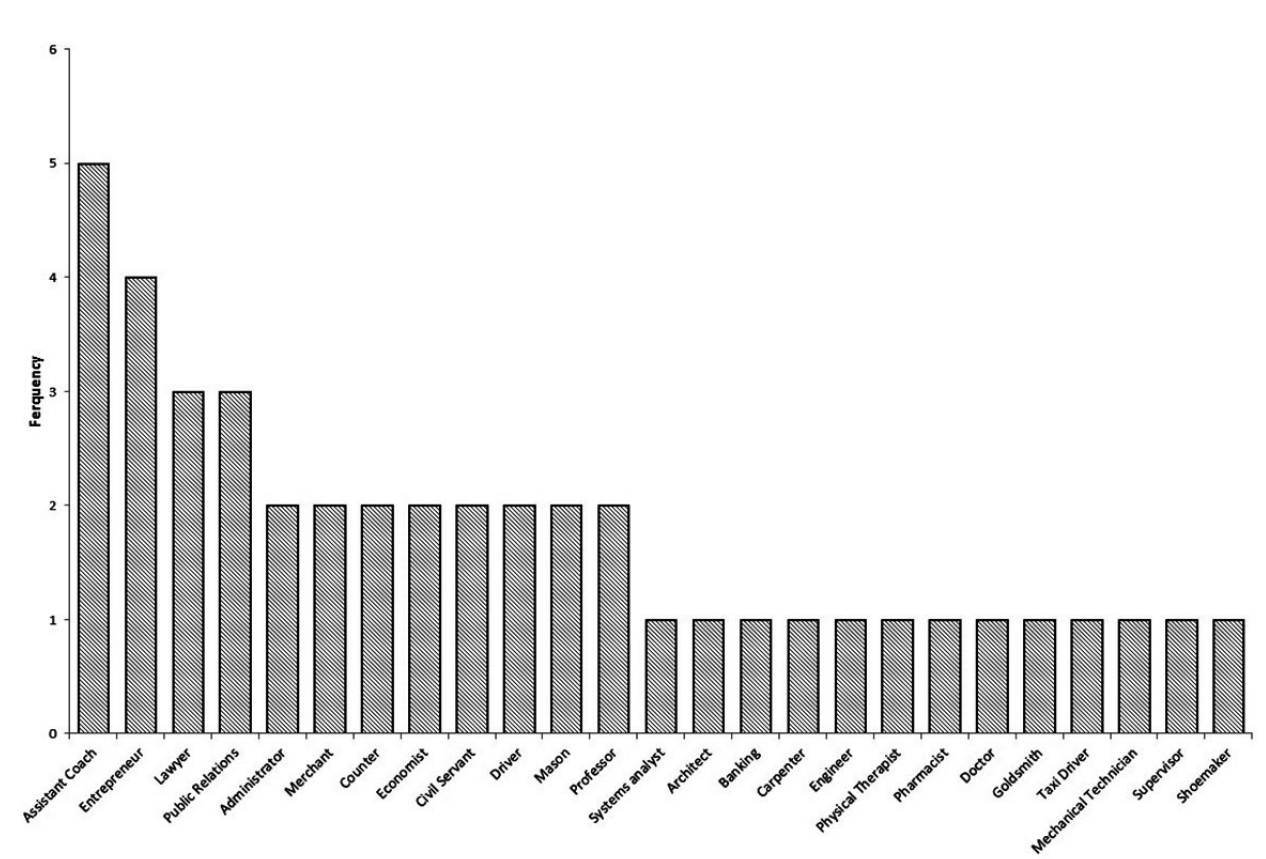
Fig. 1 - Distribution of participants according to their occupation.